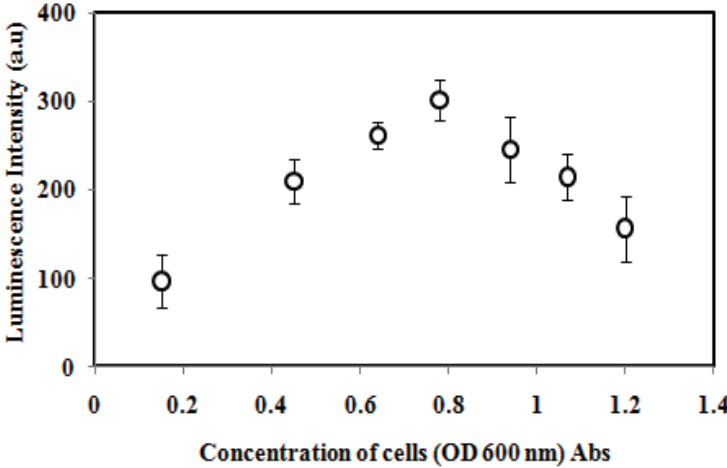
Figure 2. Luminescence intensity of the microbial biosensor at various A. fischeri cell concentrations from 0.15–1.22 OD 600